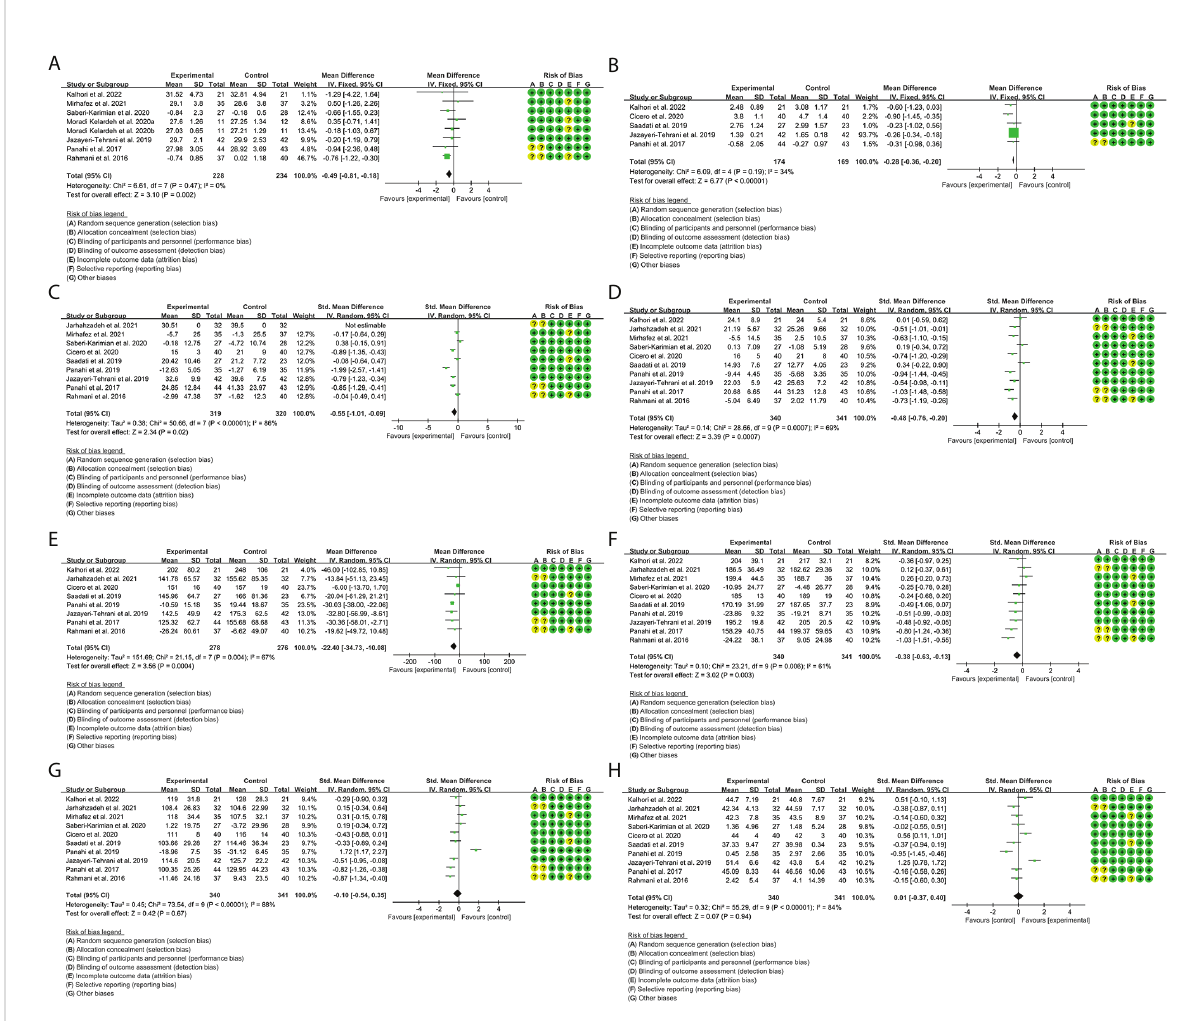
FIGURE 3 Outcomes in curcumin treatment ( A : BMI; B : HOMA-IR; C : ALT; D : AST; E : TG; F : TC; G : LDL-C; H : HDL-C). CI, con fi dence interval; SD, standard